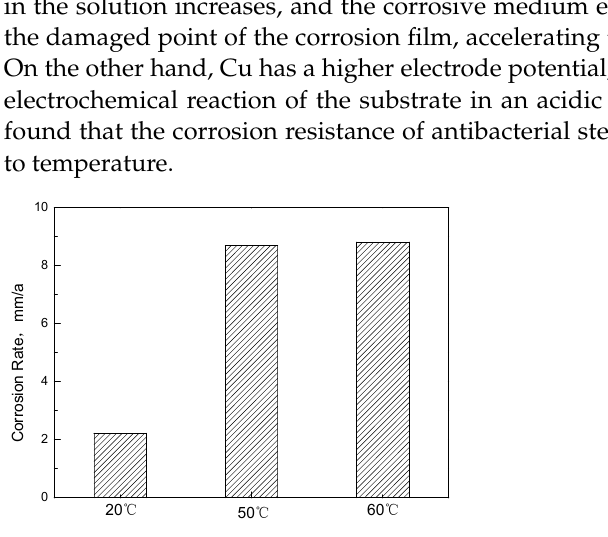
Figure 4. Corrosion rate of antibacterial alloy steel measured under different temperatures.